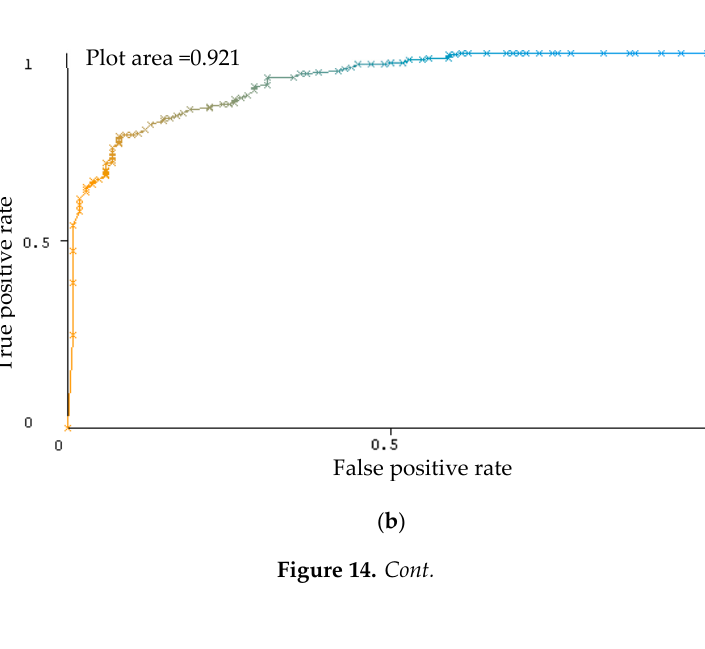
ROC curve for Adaboost-RF 10-fold cross validation method